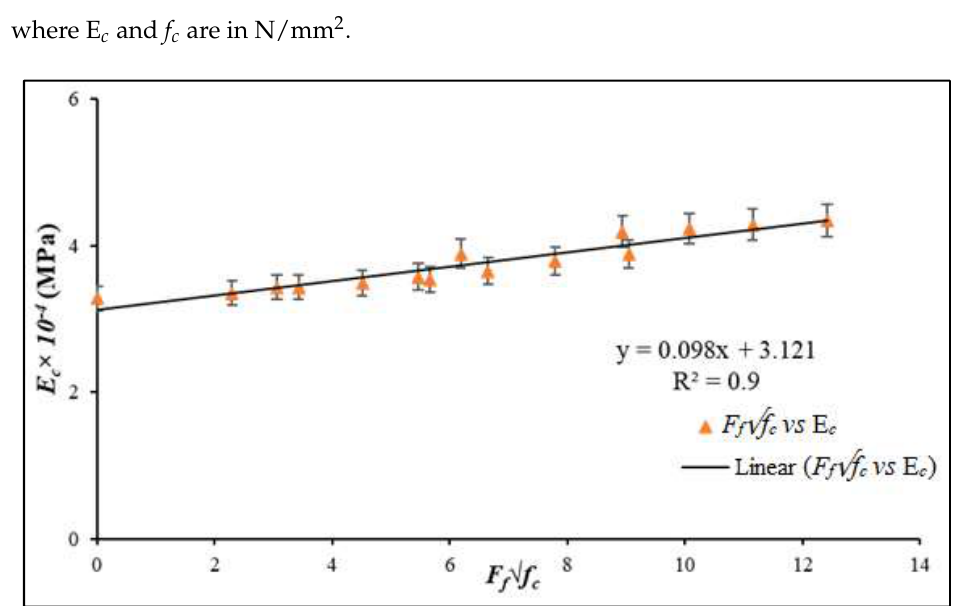
Figure 10. Relationship between E c and F f √ f c .